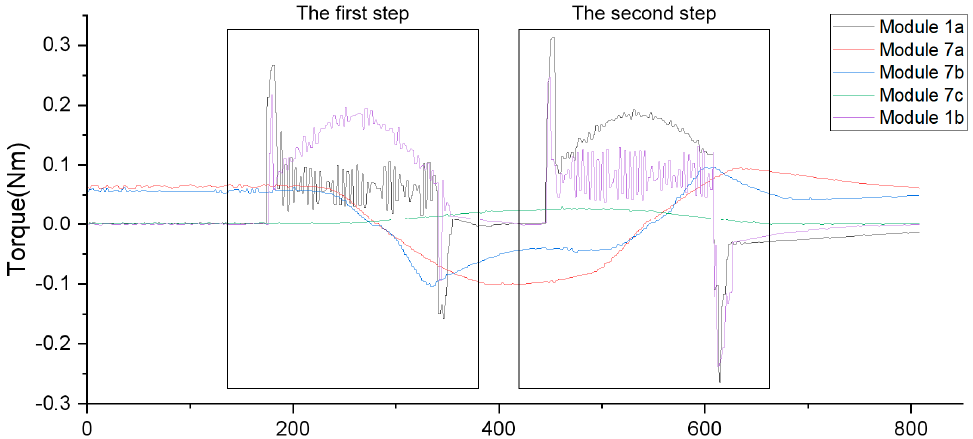
Figure 13. Motor torque waveforms of turning-around gait.